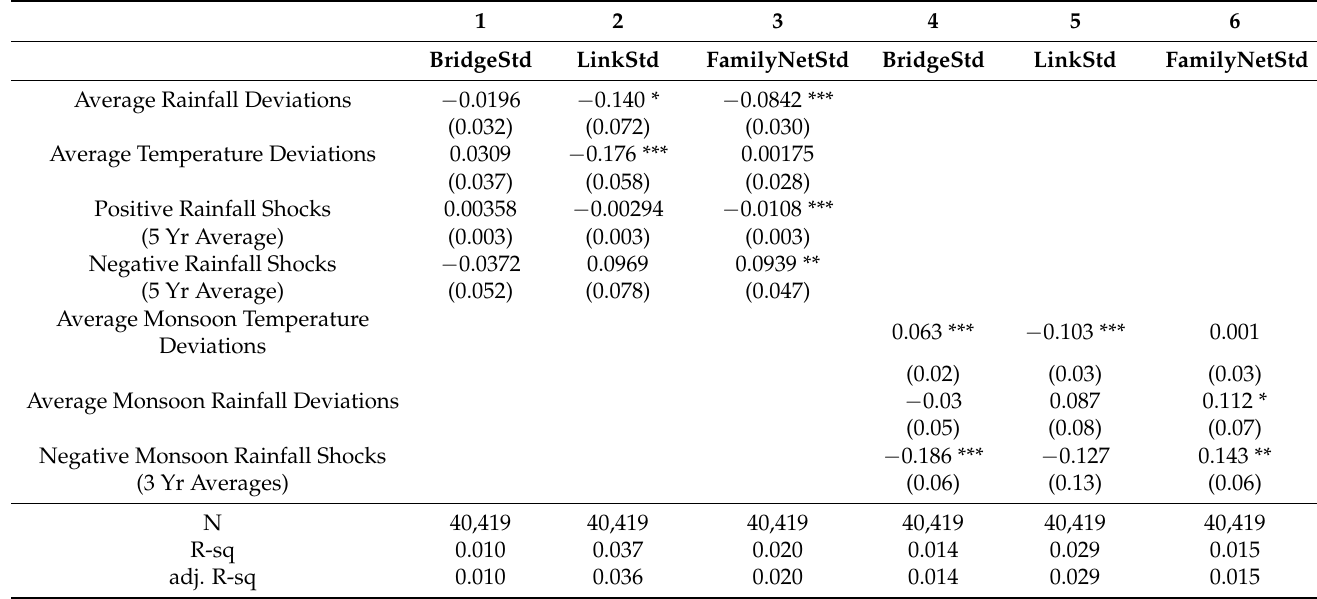
Table A5. Results assessing the impacts of negative rainfall shocks on social networks based on 5-year (averages) and rainfall shocks occurring during India’s monsoon